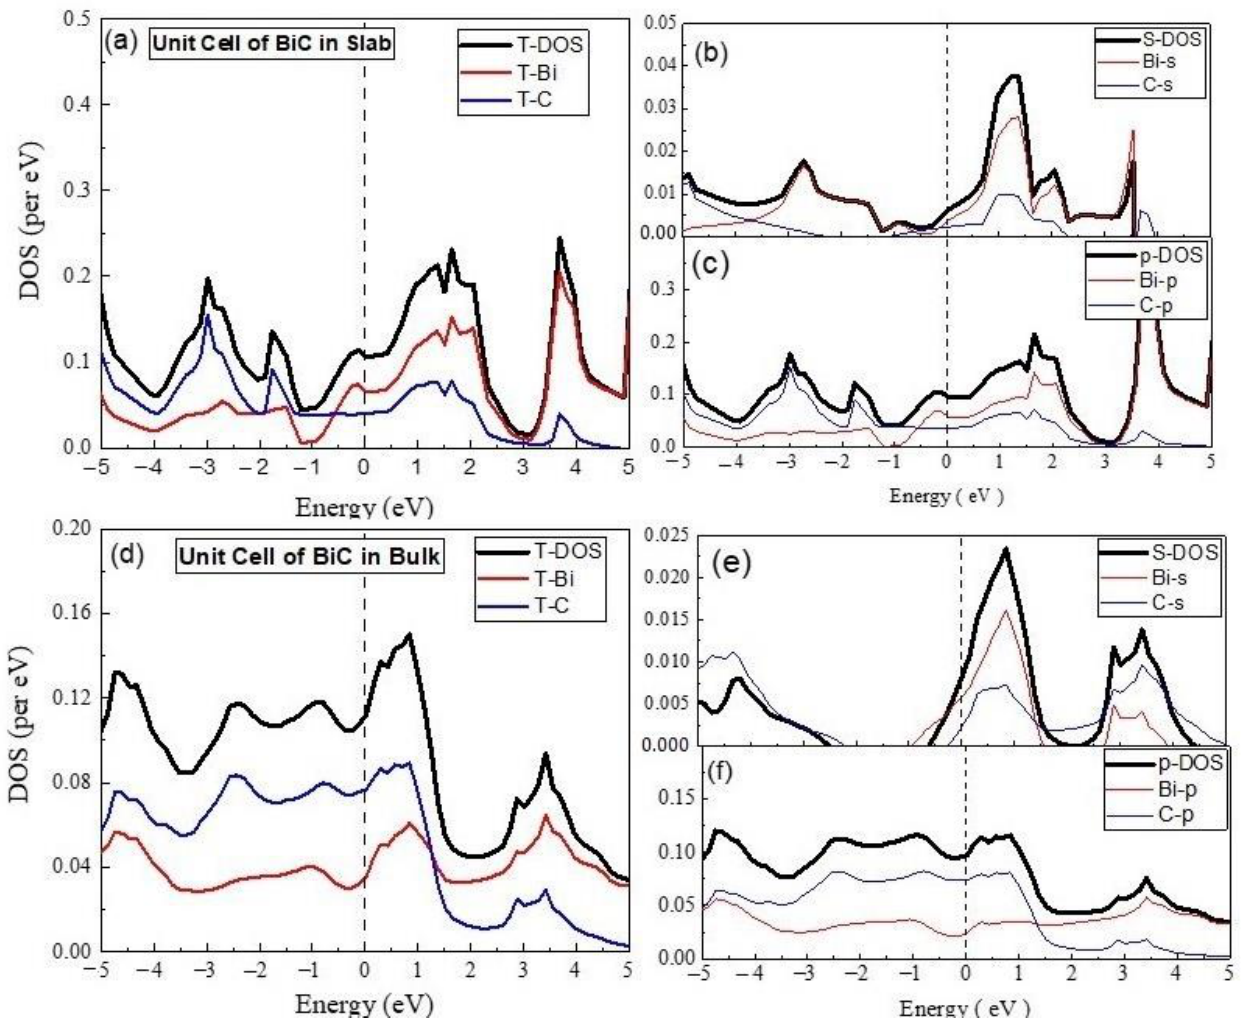
Figure 2. The calculated total density of states (TDOS) and partial density of states for BiC unit cell ( a ) TDOS of slab ( b ) s-DOS of slab ( c ) p-DOS of slab ( d ) TDOS of bulk ( e ) s-DOS of bulk ( f ) p-DOS of bulk. The Fermi level was adjusted at 0 eV.